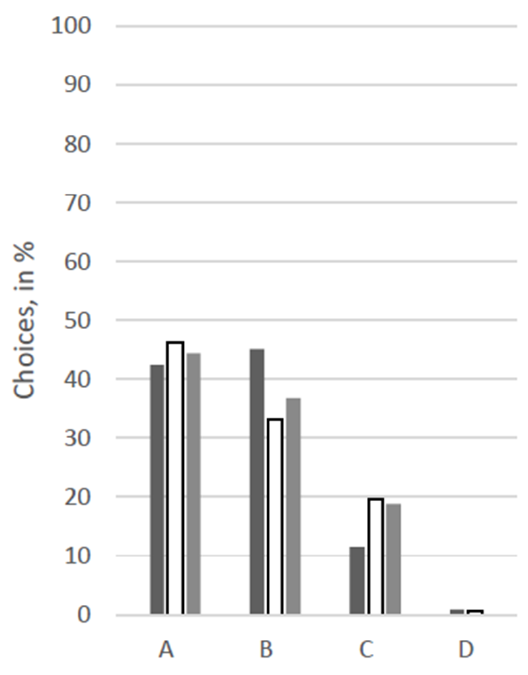
Figure 5. Answers for the scenario “30-year-old human in a coma” in %. Legend: black: human medicine group; white: control group; grey: veterinary medicine group; A: Euthanasia tablet, B: Sedation tablet, C: Potentially curative tablet, D: No treatment .